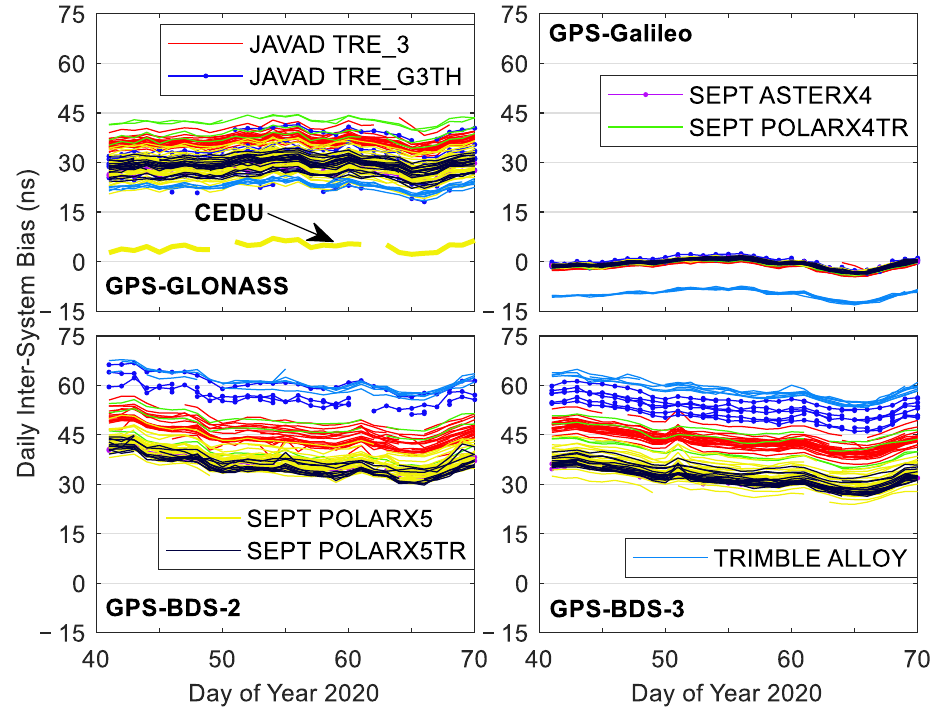
Figure 7. Time series of daily ISBs for each station (characterized by the receiver types) on DOY 41 – 70, 2020.